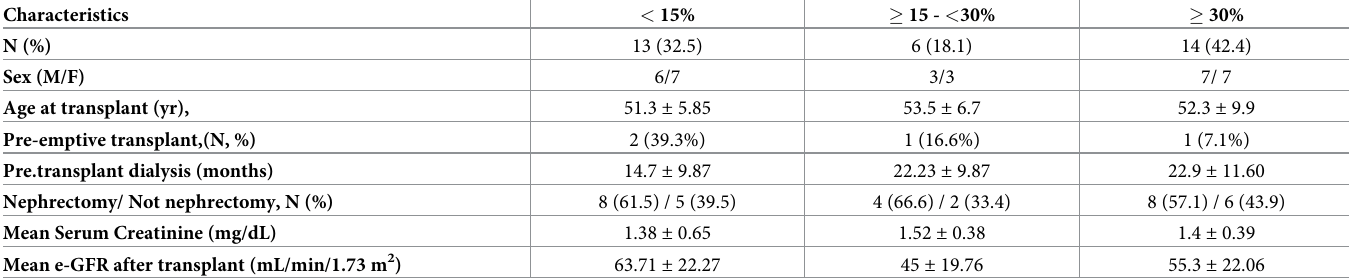
Table 3. Patients with total kidney volume decrease divided into 3 subgroups according to the degree of reduction. In patients with different variation in size of the two kidneys, it was considered the kidney with the highest variation.